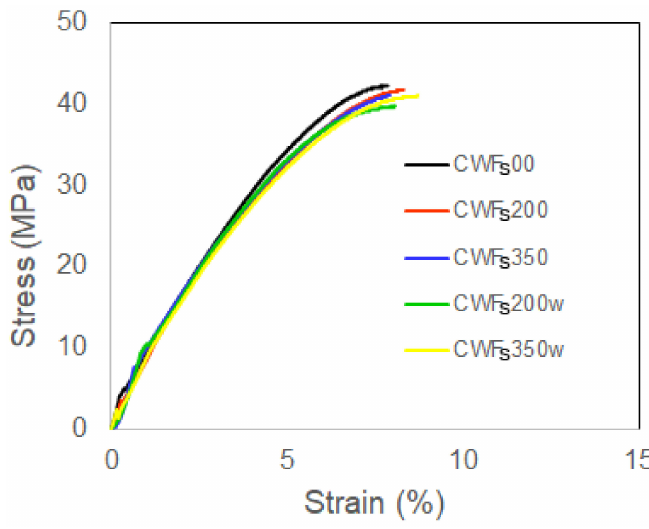
Figure 3. Stress–strain curves of CWF S type composites: CWF S 00, CWF S 200, CWF S 350, CWF S 200w, and CWF S 350w. Table 2. Tensile and fatigue strength of different types of WF filled PP